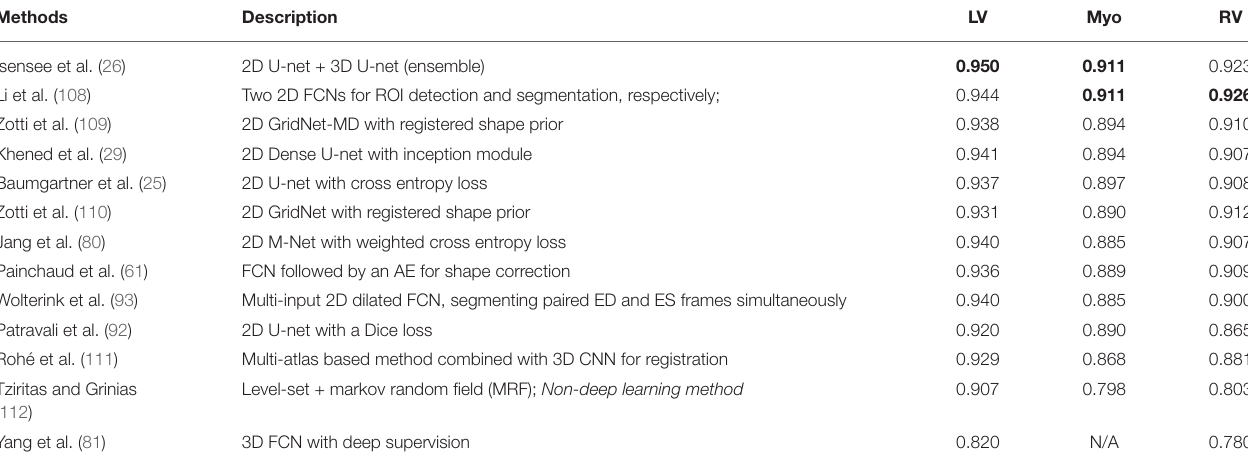
TABLE 2 | Segmentation accuracy of state-of-the-art segmentation methods verified on the cardiac bi-ventricular segmentation challenge (ACDC) dataset (17).